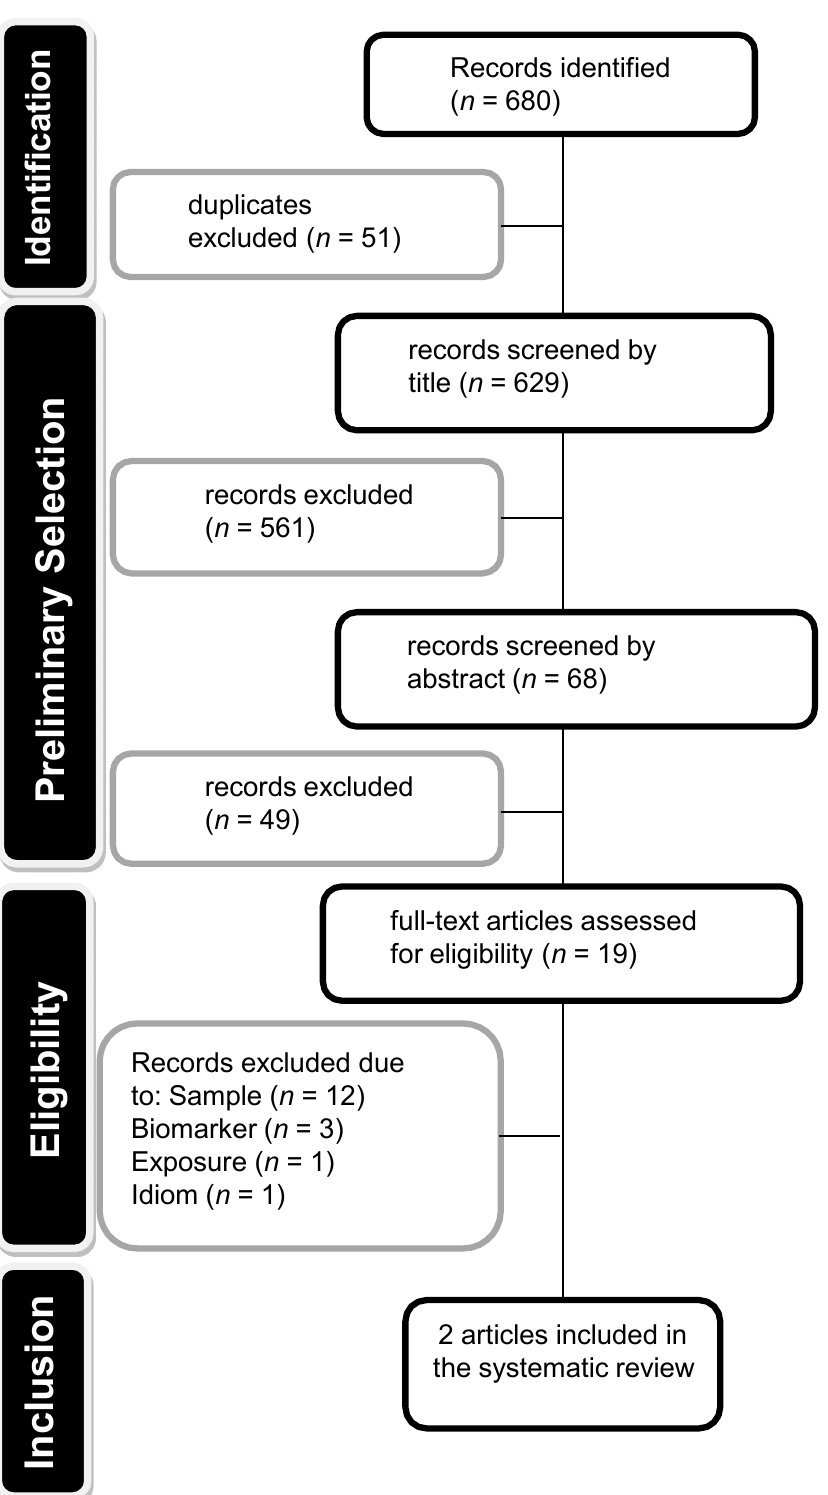
Figure 1. Flow chart of article identification, retrieval, and inclusion, for the systematic review. The two final eligible articles included in this systematic review were published in English, but they are from different countries, one from Europe and the other from North America (Table 2). We found one study published in 1993 [24], but Medin et al. [25] was more recent, published in 2016.